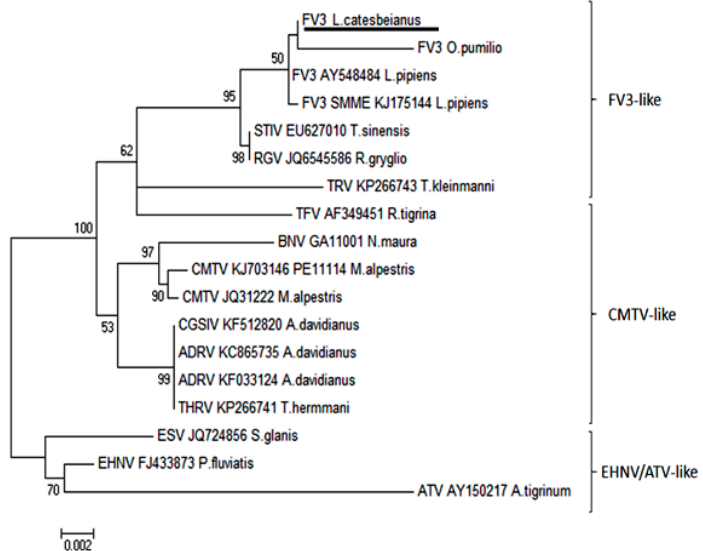
Figure 6. Phylogeny of five partial ranavirus gene sequences (1000 bootstrap values). The Mexican isolate FV3 L. catesbeianus (underlined) clusters closely within the FV3 ranavirus clade. Isolates and Genbank numbers used: Frog virus 3/ Lithobates catesbeianus /2018/Mexico (GenBank accession numbers for partial sequences available in Supplementary Table S1), frog virus 3 (AY548484), frog virus 3 isolate SMME (KJ175144), tortoise ranavirus isolate 1 (882/96) (KP266743), Bosca’s newt virus